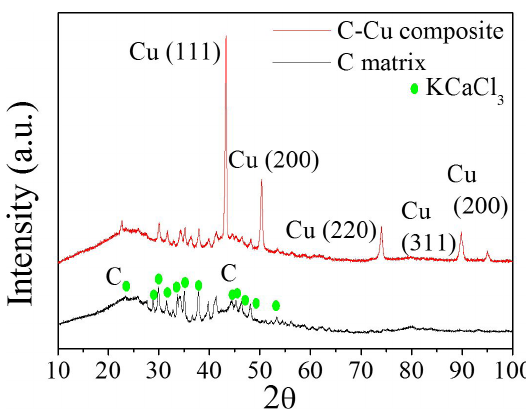
Figure 6. XRD spectra of C matrix and C-Cu composite.